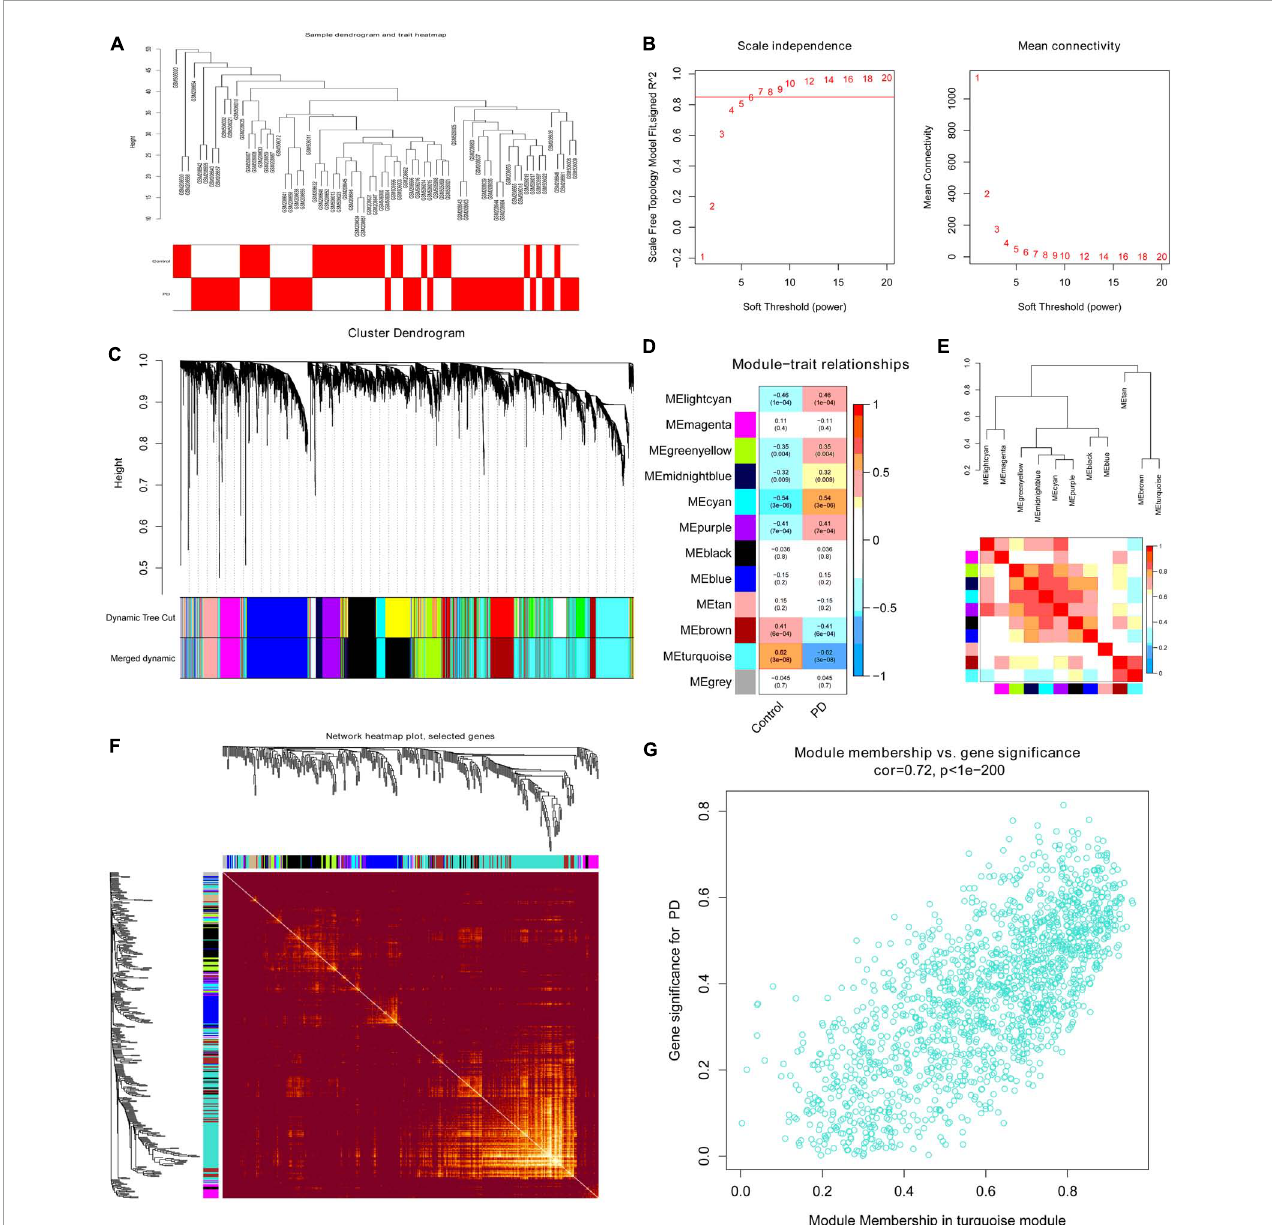
FIGURE4 The WGCNA process for the integrated dataset. (A) Clustering dendrogram of 38 PD substantia nigra tissue and 29 normal substantia nigra tissue gene expression patterns. (B) Analysis of the scale-free fit index (left) and the mean connectivity (right) for various soft-thresholding powers; the power value β was set as 7 for further analysis. (C) Clustering dendrograms of 5000 genes based on a dissimilarity measure (1-TOM). Seventeen co-expression modules were constructed with various colors under the gene tree, and similar modules were merged into twelve modules with a height cutoff of 0.25. Each color represents one module. (D) Heatmap of associations between modules and clinical traits. Correlation coefficients and p -values are shown in each cell, which were obtained by the intersection of rows and columns. The turquoise module correlated significantly with PD. (E) Visualization of the eigengene dendrogram and eigengene adjacency heatmap. Red indicates more similarity, and blue indicates less similarity. (F) Visualization of 400 random genes from the WGCNA network using a heatmap plot to depict the TOM among all modules included in the analysis. A redder background indicates a higher module correlation. (G) Scatter plot of module membership vs. gene significance for PD in the turquoise module. WGCNA, weighted gene co-expression network analysis; TOM, topological overlap matrix; PD, Parkinson’s disease.